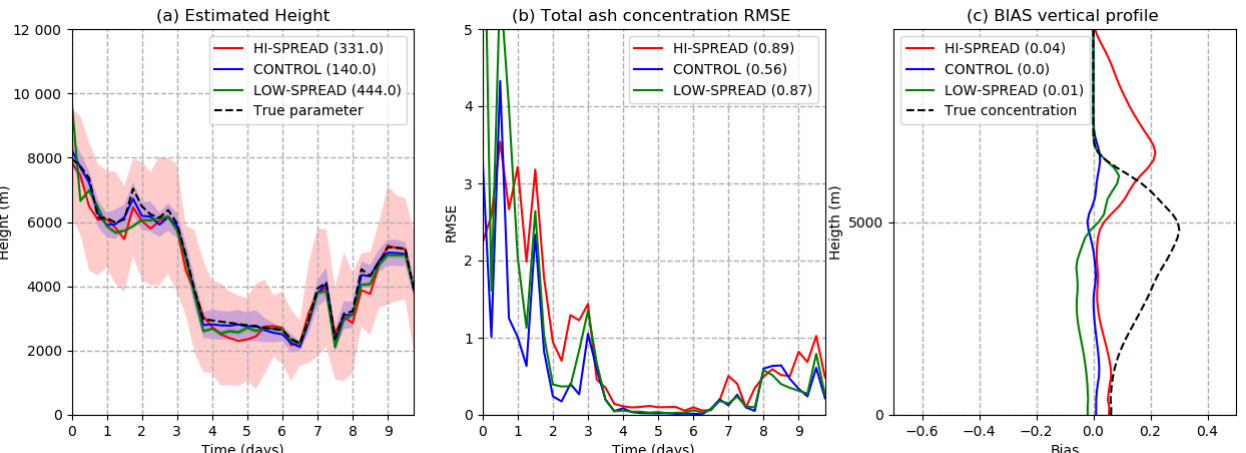
Figure 11. (a) Estimated h as a function of time for the HI-SPREAD (red line), CONTROL (blue line), and LOW-SPREAD (green line). The shading surrounding the estimated values represents ± 1 standard deviation, and the black dashed line indicates the true parameter value. (b) Spatially averaged total ash concentration 6h forecast RMSE as a function of time (10 − 3 gm − 3 ). Line color code as in (a) . (c) Temporally averaged 6h forecast bias as a function of height (10 − 3 gm − 3 ). Line color code as in (a)